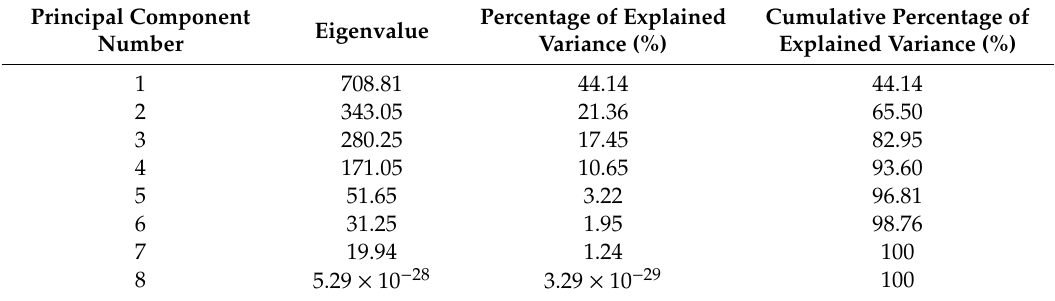
Table 5. Values of Eigenvalue and percentage of variance with cumulative corresponding to each principal component.